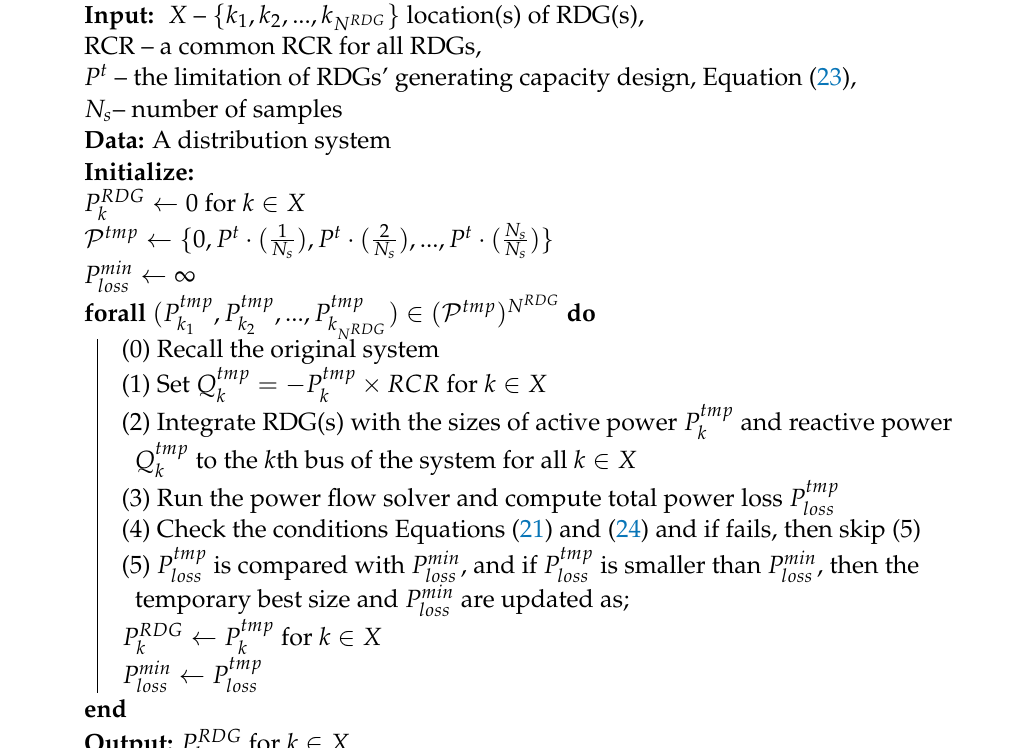
Algorithm 2: Optimal size of